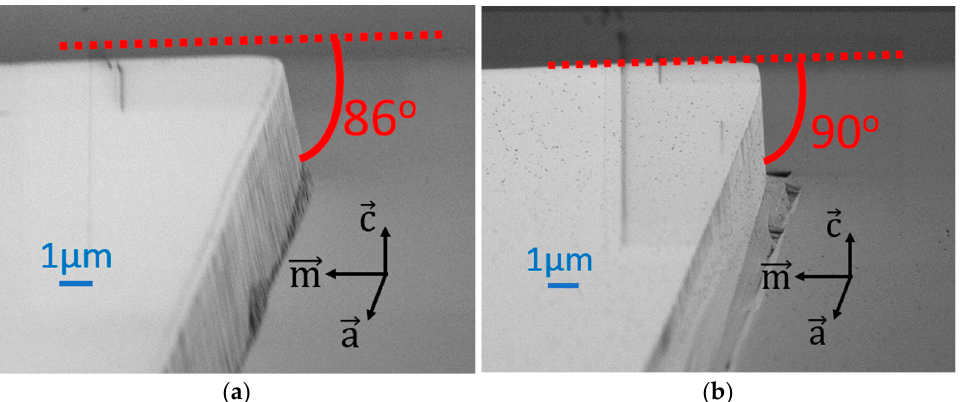
Figure 3. SEM images of the test sample of the laser epitaxial structure ( a ) after reactive ion etching, ( b ) the same edge after RIE and TMAH wet etching.